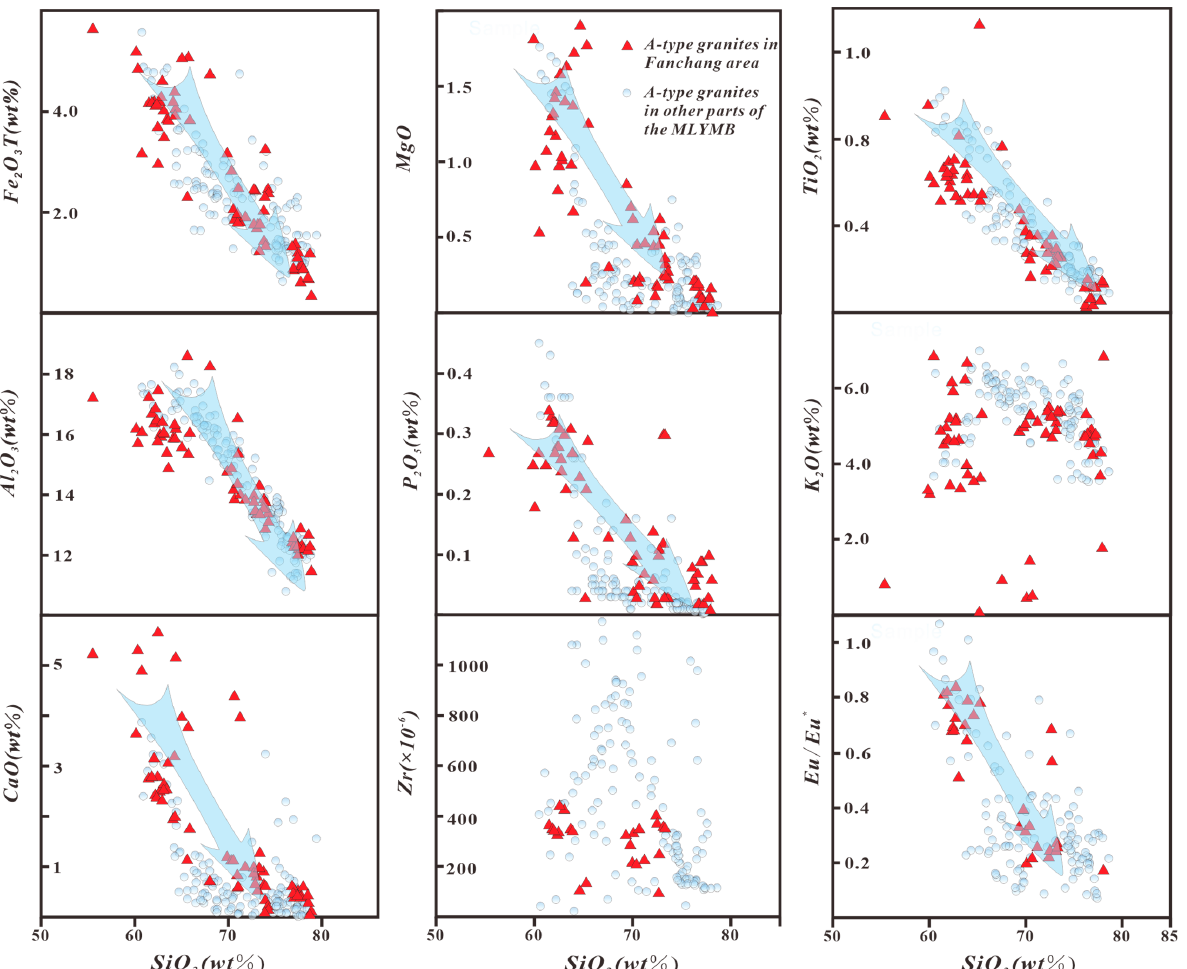
Figure 5. Harker diagrams of intrusive rocks in the FVB and other areas in the MLYMB. Figure 6. Harker diagrams of intrusive rocks in the FVB and other areas in the The Zr-Zr/Y covariant diagram (Figure 6) can further identify the controlling role of orthopyroxene during the fractional crystallization or partial melting process. It can crys- tallize as separate cumulate phases during the crystallization process or remain as resid- ual phases during the partial melting process [152].